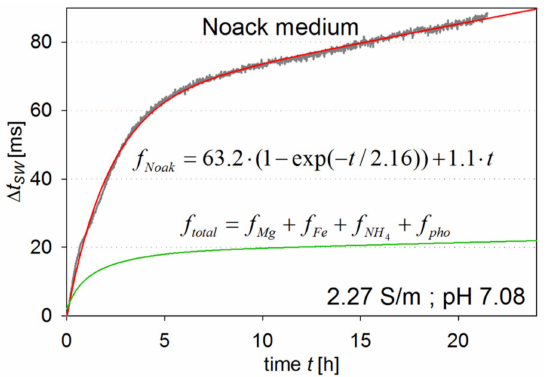
Figure 3. Comparison of ∆ t sw transients after transferring the sensor probe from SEL to MS medium ( top ) and the sum of individual components of medium as derived from their fitting functions ( bottom